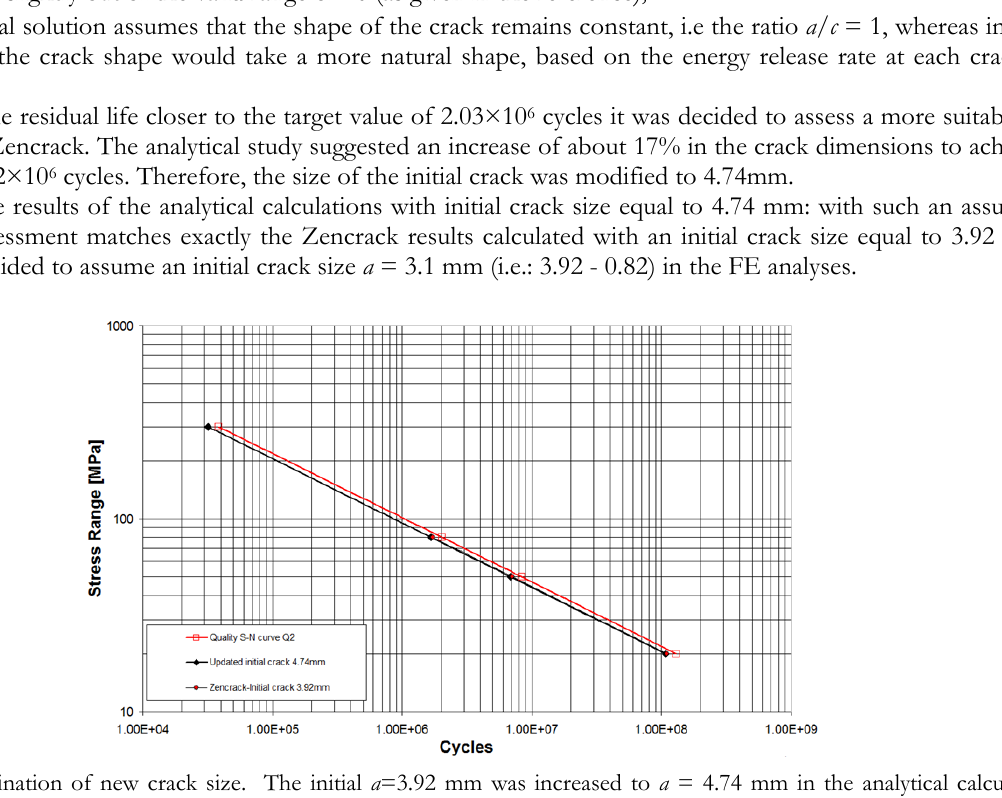
Figure 10: Determination of new crack size. The initial a =3.92 mm was increased to a = 4.74 mm in the analytical calculation to match Zencrack results.